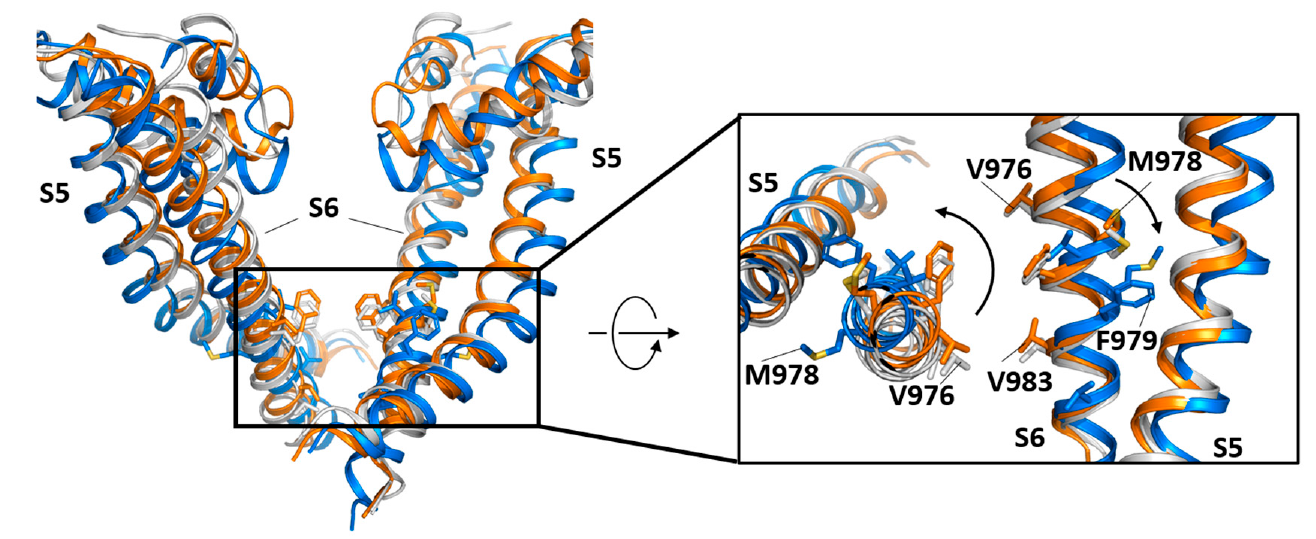
Figure 8. TRPM8 channel gating. The image depicts the S5–S6 transmembrane region of TRPM8 in the open state (blue marine) and the closed states C1 (grey) and C2 (orange) captured by cryo-EM. The states have been superimposed using the entire tetrameric channel. The structures correspond to mammal TRPM8 (PDB code: 8E4L (open), 8E4N (C1), and 8E4M (C2) [109]. Only two subunits are represented for simplicity (left). The open structure has the agonists C3 (cryosim-3) and AITC (allyl isothiocyanate) bound, while the C2 state has the agonist C3. All three structures have the PIP 2 bound. Large movements in S5 and S6 are observed (zoomed view; right). S5 maintains different interactions with S6 in the open or closed states. The movement of S5 is coupled to the translocation of S6 away from the central axis, leading to channel opening. Arrows indicate S6 movement and side chain rotations. As for TRPV1, structural information on gating by cold temperature is awaited. In terms of temperature sensitivity, TRPM8 resembles TRPV1 exhibiting a large Q 10 >